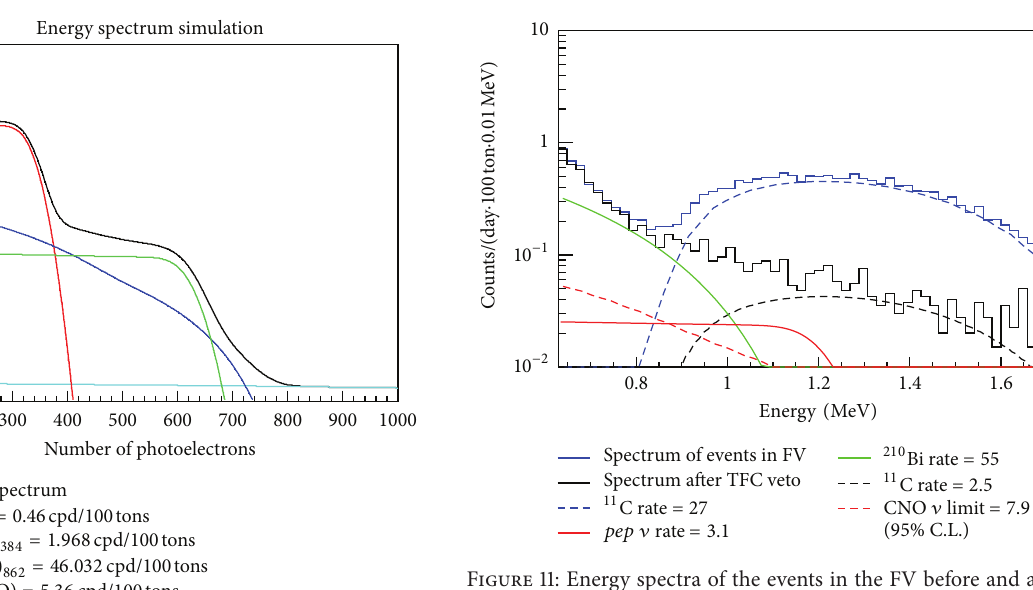
Figure 11: Energy spectra of the events in the FV before and after the TFC veto is applied. The solid and dashed blue lines show the data and estimated 11 C rate before any veto is applied. The solid black line shows the data after the procedure, in which the 11 C contribution (dashed) has been greatly suppressed. The next largest background, 210 Bi,andtheelectronrecoilspectraofthebestestimate of the pep neutrino rate and of the upper limit of CNO neutrino rate are shown for reference. Rate values in the legend are quoted in counts/(day ⋅ 100ton) from